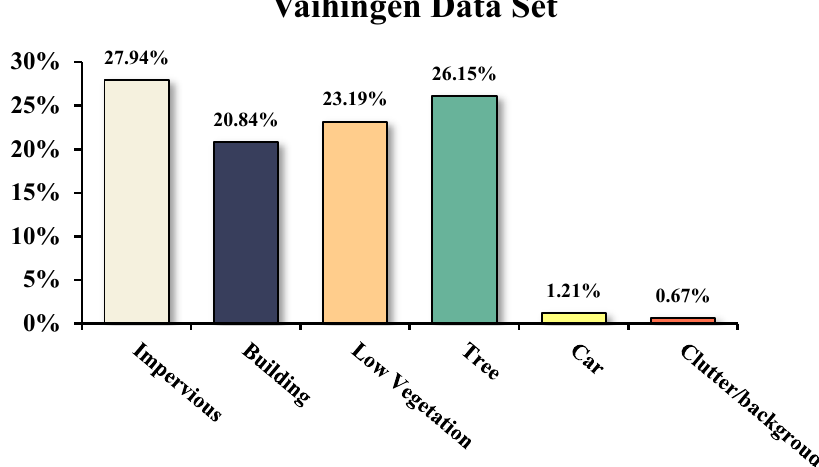
Figure 9. Proportion of each type of feature in the Vaihingen data set.